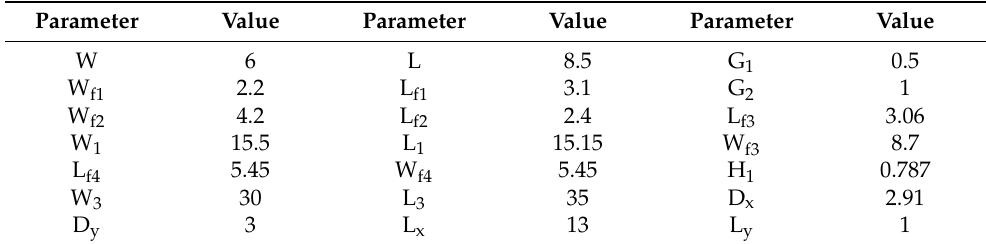
Figure 1. Overview of design process. ( a ) Single antenna; ( b ) Array structure; ( c ) MIMO configuration; ( d ) Decoupler and DGS incorporation. Table 1. Optimized design parameters (all in millimeters).